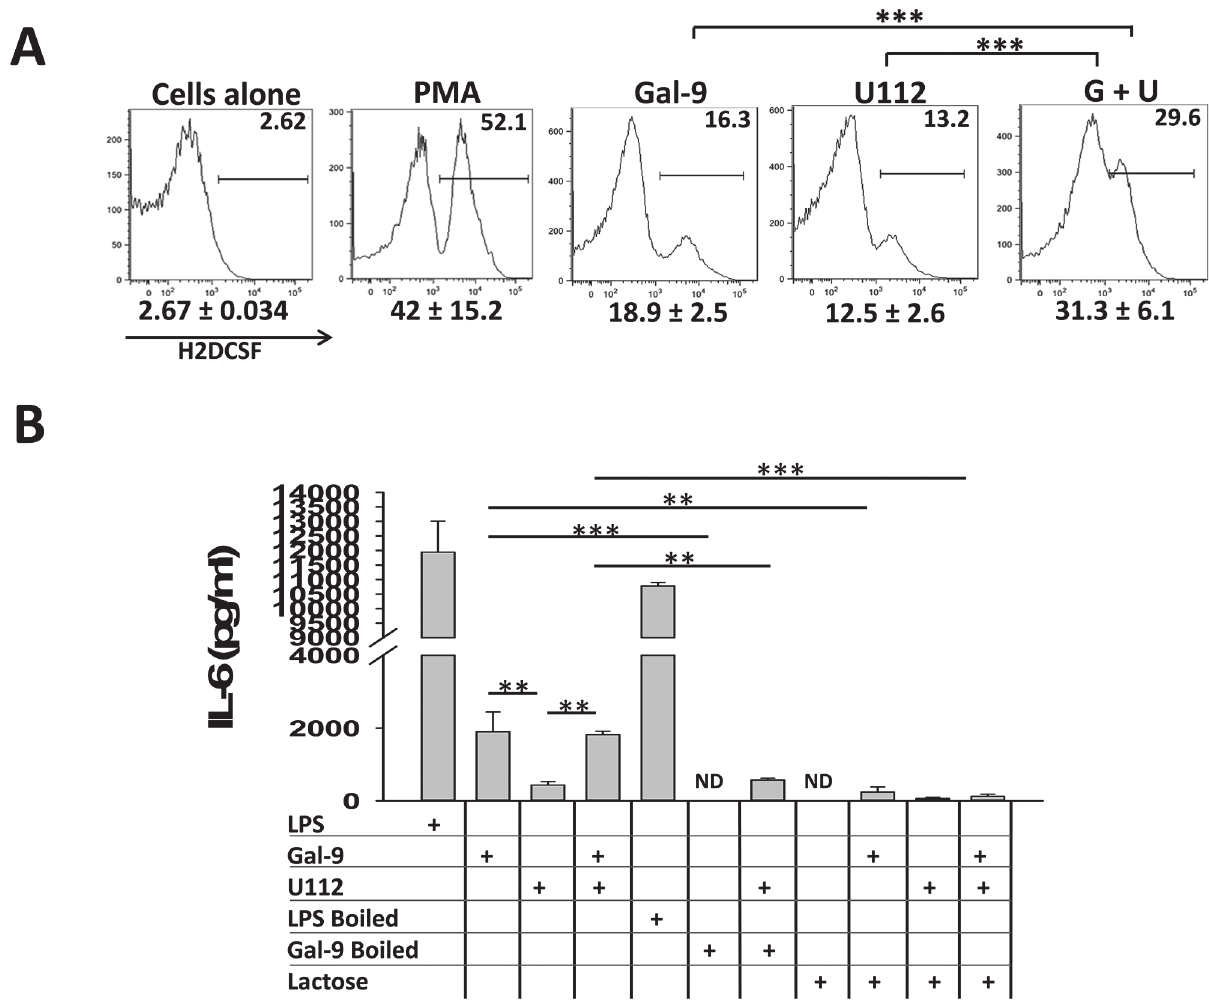
Fig 4. Galectin-9 regulates F.n. infection induced inflammatory response in vitro. (A) Peritoneal neutrophils were isolated from mice 12 – 14h after injection with 4% thioglycollate and were stimulated with F.n. at an MOI 50 with or without pre-treatment with purified recombinant galectin-9 (15 μ g/ml). Stimulation with galectin-9 alone or phorbol myristate acetate (PMA, 10ng/ml) was used as a control. Production of reactive oxygen species (ROS) was measured one hour post-stimulation by flow-cytometry using Fc-OxyBURST dye following the manufacturer ’ s instructions. Numbers below the plots depict average percent of ROS positive cells from 3 independent experiments. Plots from a representative of these 3 independent experiments are shown. (B) Bone marrow derived macrophages (BMDMs) from C57Bl/6 wild-type mice were stimulated with F.n. Strain U112 at an MOI of 50 with or without pretreatment with 15 μ g/ml of purified recombinant galectin-9. UltraPure E.coli LPS (10ng/ml) and galectin-9 with and without heat-denaturation (boiled at 100°C for 45 min) as well as competitive inhibition with lactose (25mM) were used as controls to test the specificity of galectin-9 effect, as described in methods. Culture supernatants were collected 24h after infection and the amount of IL-6 was measured by ELISA. The data shown is average of three independent experiments. Statistical analysis between the data sets was performed by Two-way ANOVA with Tukey post-test where * p < 0.05; ** p < 0.005; *** p <